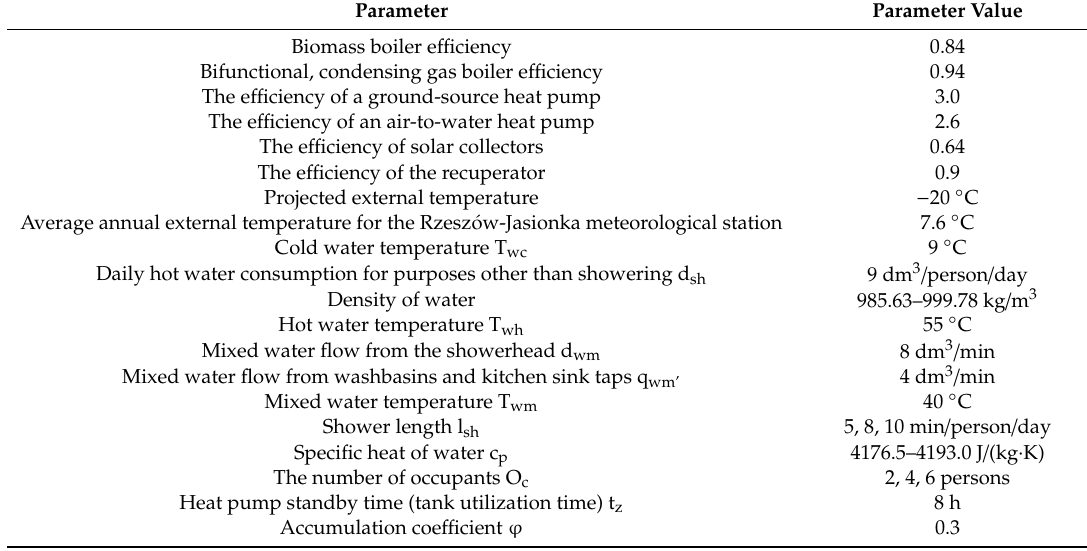
Table 4. Data accepted for calculations for heating installations.